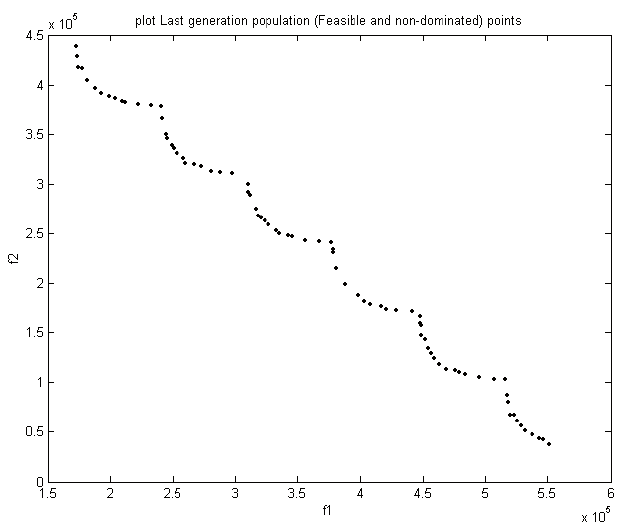
Fig. 7. Pareto Front at the convergence for maximization problem of A11 (F 1 ) and A22 (F 2 ) for 8